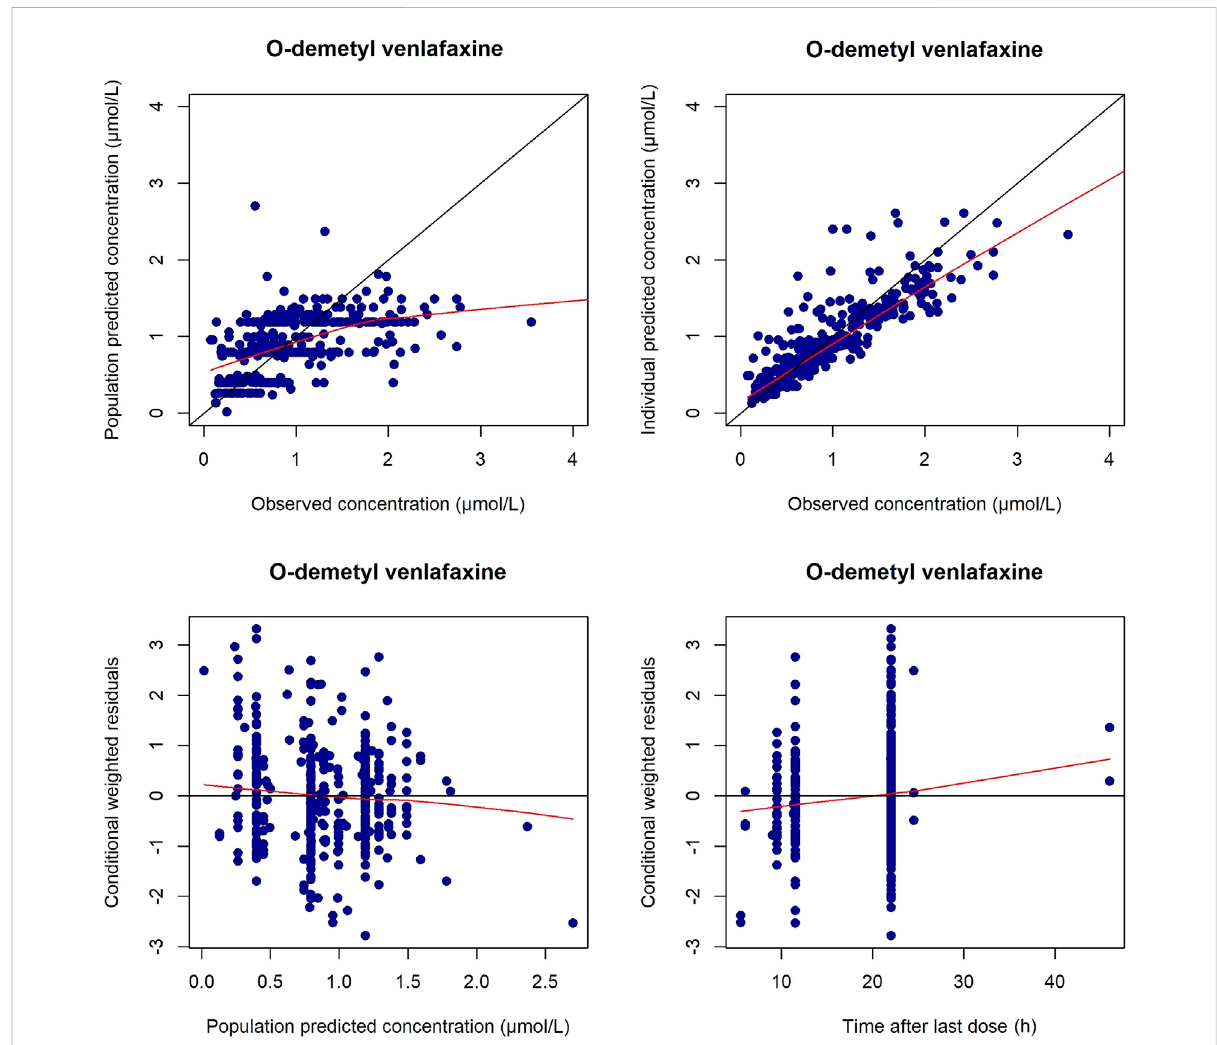
FIGURE 5 DiagnosticplotsforODVinthe fi nalPPKmodel.Theleftupperistheplotofthepopulation-predictedconcentrationsversustheobservedODV concentrations; the right upper is the plot of the individual population-predicted concentrations versus the observed ODV concentrations; the left lower represents the conditional weighted residual error versus the population-predicted ODV concentrations; the right lower represents the conditional weighted residual error versus the time after last